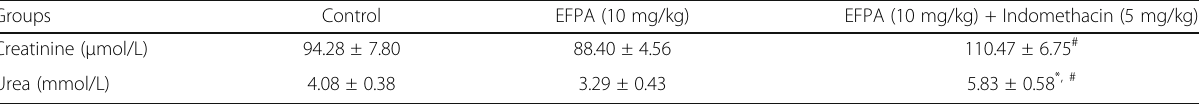
Table 4 Effects of EFPA (10 mg/kg) and EFPA (10 mg/kg) + indomethacin (5 mg/kg, 1 h pretreatment) administered i.p. on plasma levels of creatinine and